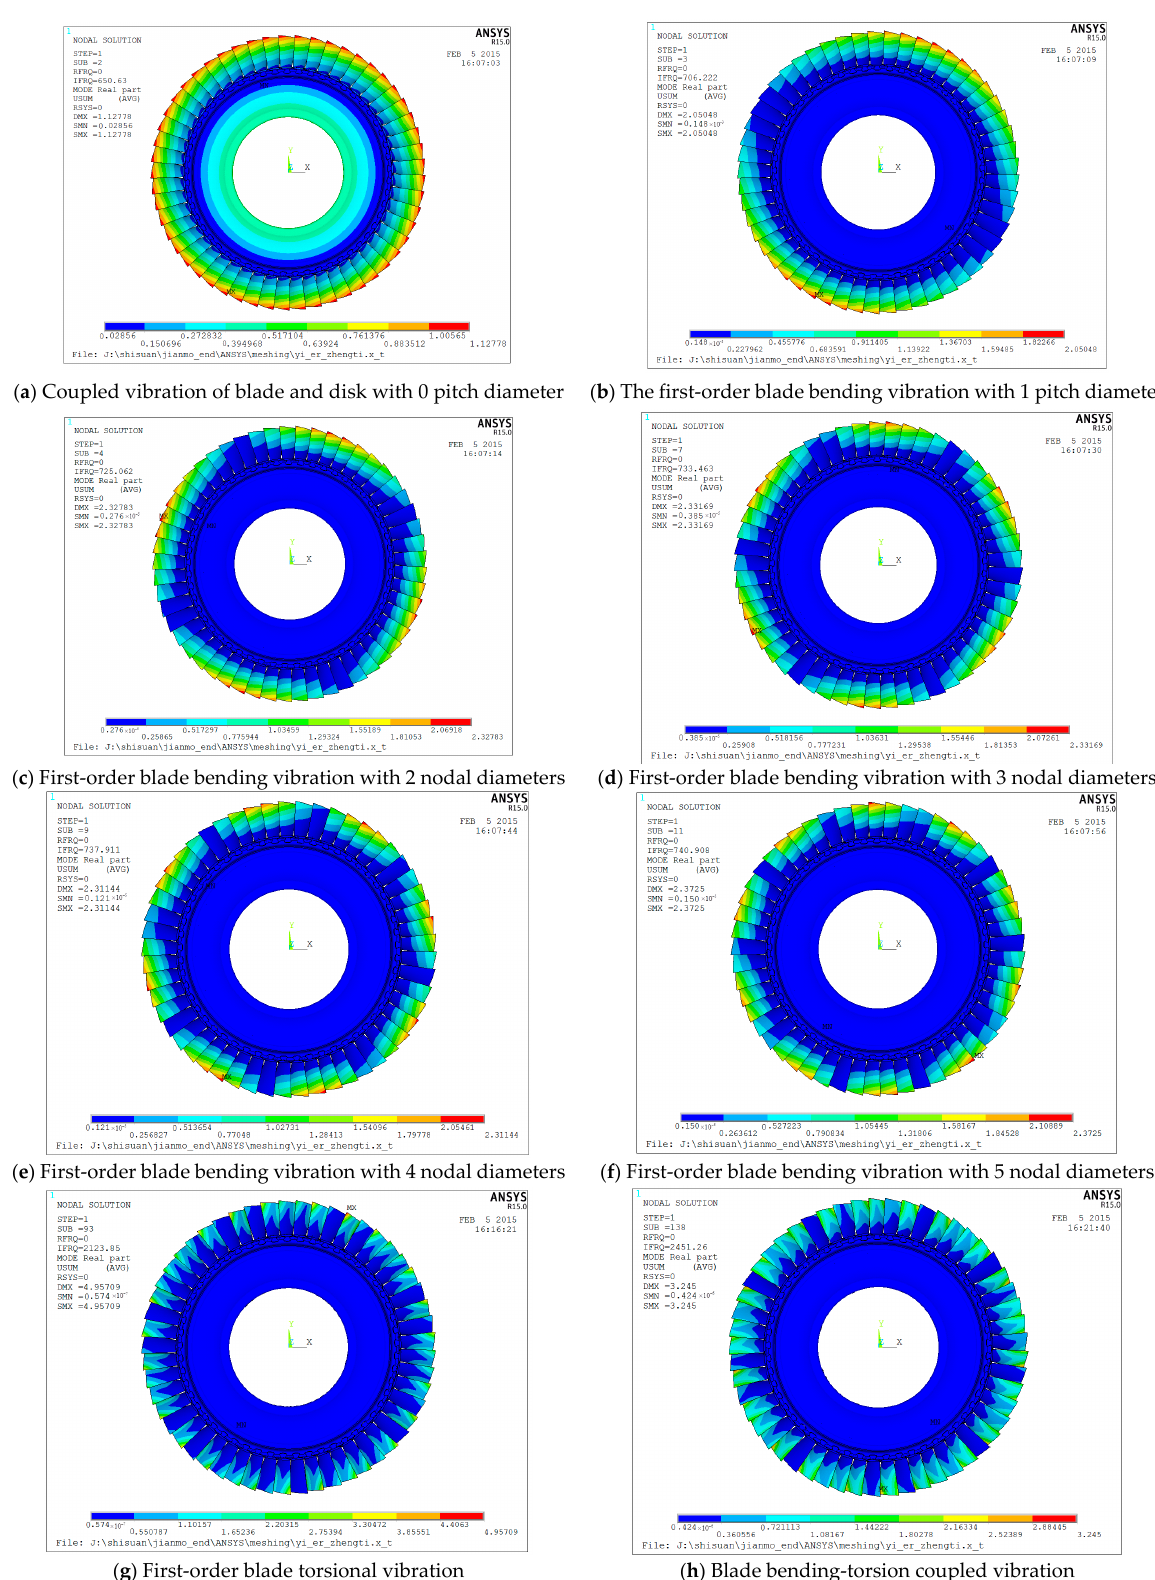
Figure 13. Mode pattern of a typical order of the second-stage bladed disk